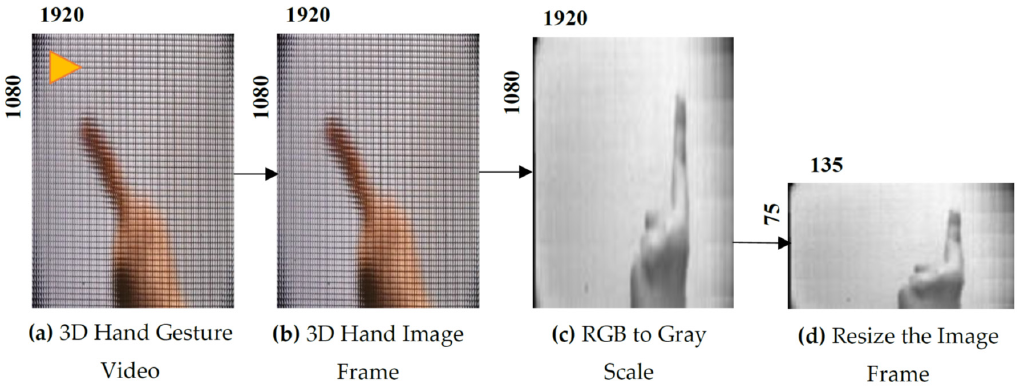
Figure 5. Pre-processing for 3D micro hand gesture video. ( a ) Record 3D micro hand gestures using the Holoscopic imaging system camera. ( b ) 3D micro hand gestures will be extracted as an image. ( c ) Convert the 3D image from RGB to grey scale. ( d ) Resize the 3D image from 1920 × 1080 pixel to 135 × 75 pixel.